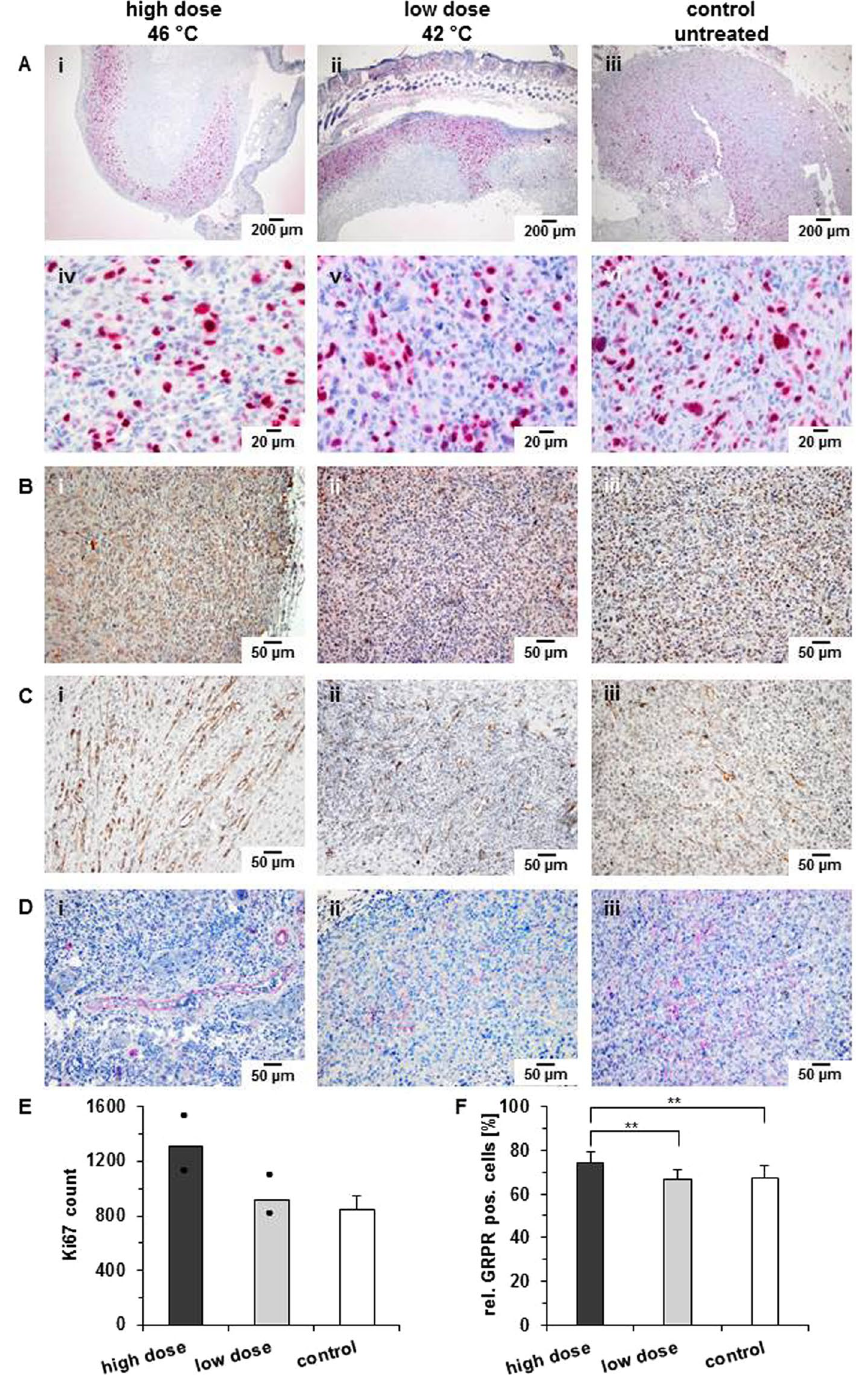
Figure 5. Hyperthermia impacts proliferation, GRPR-expression of tumor cells as well as the features of associated vessels. ( A ) Representative images of immunohistochemical staining of Ki67. Used magnification: 40 fold (i–iii) and 400 fold (iv–vi). ( B ) Representative images of immunohistochemical staining of GRPR. Used magnification: 200 fold ( C ) Representative images of immunohistochemical staining of CD31, magnification: 200 fold. ( D ) Representative images of immunohistochemical staining of α -SMA, used magnification: 200 fold. ( E ) Quantitative analysis of immunohistochemical staining of proliferation marker Ki67. ( F ) Analysis of immunohistochemical staining of GRPR by as proportion in relation to control ( ** p ≤ 0.01). Animals were treated either with low dose hyperthermia (42 °C for 1 h) or high dose hyperthermia (46 °C for 1 h). Controls were not subjected to any hyperthermia treatment. All data refer to 8 days post hyperthermia. For control of antibody reactivity see Supplementary Figure